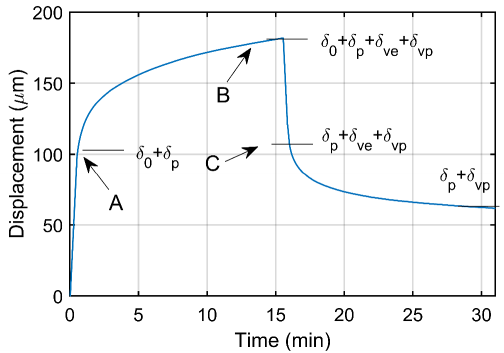
Figure 2. SPCRT curve: punch displacement versus